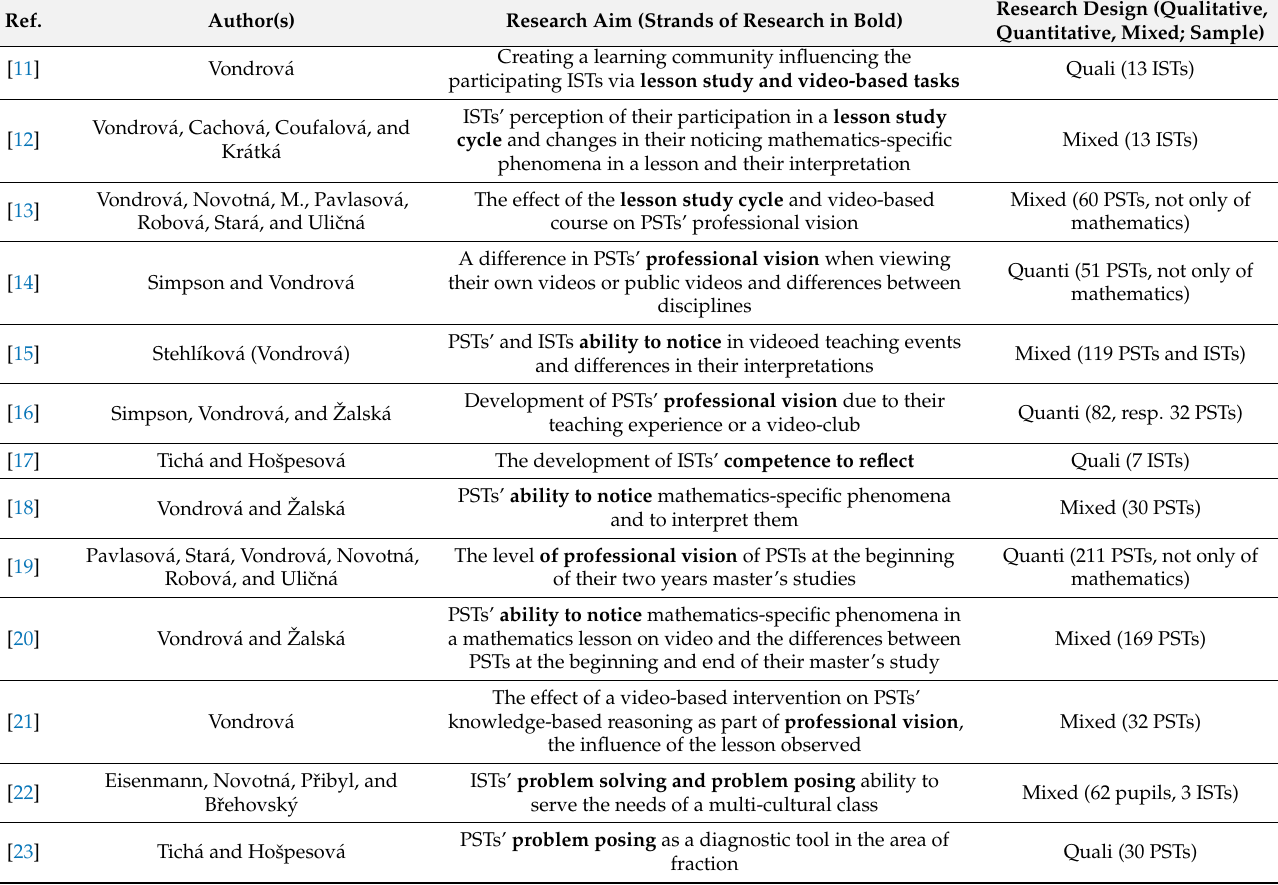
Table 1. Overview of studies included in the